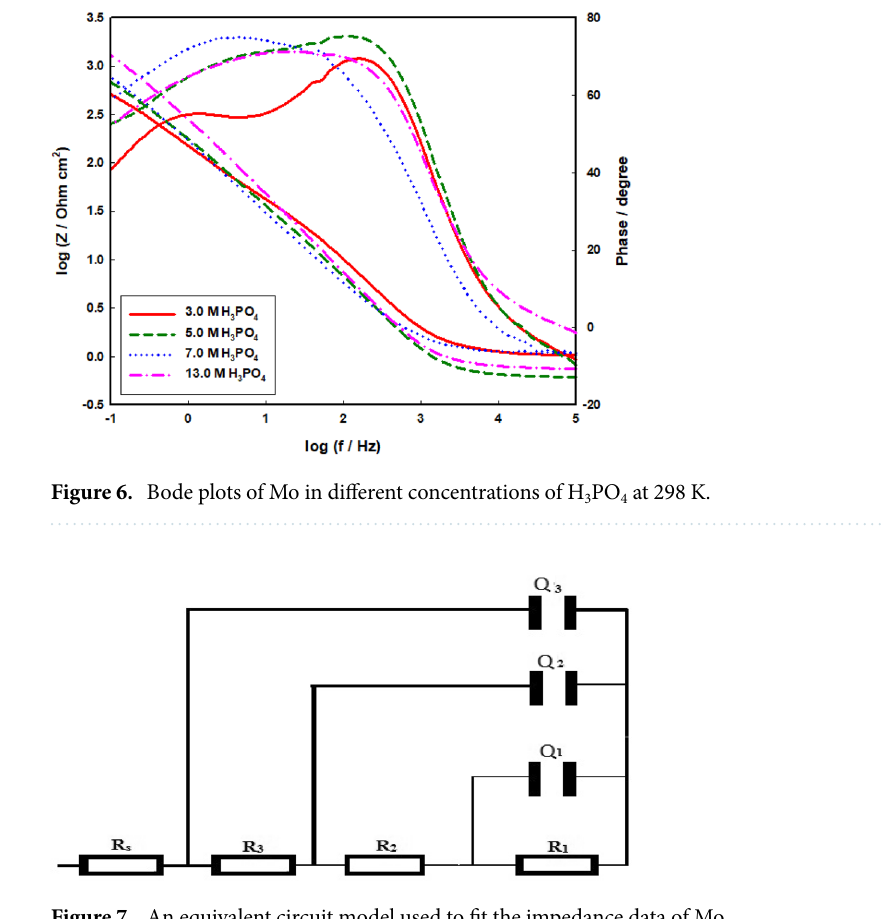
Figure 7. An equivalent circuit model used to fit the impedance data of Mo.